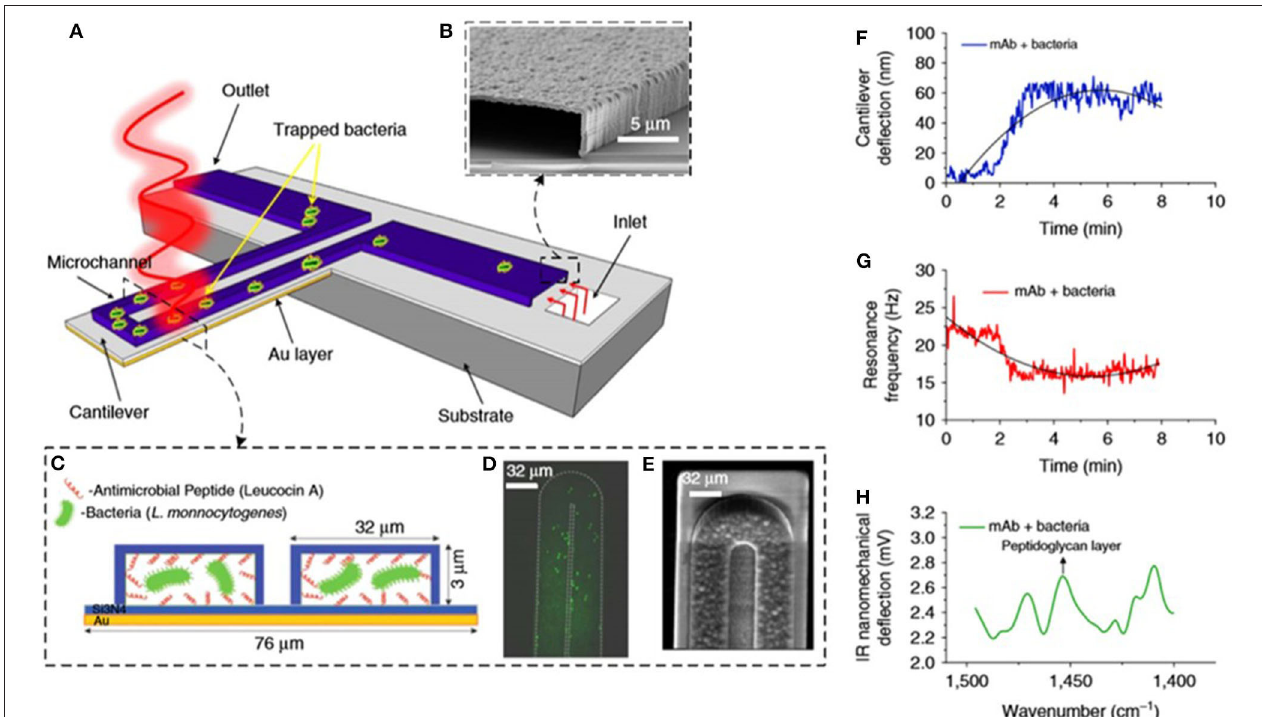
FIGURE 4 | Bacteria detection with multimode nanomechanical sensors. (A) Schematic representation of the microfluidic gold-coated cantilever. (B) Cross-section SEM image of the inlet channel. (C) Cross-section of the functionalized microchannel with adsorbed bacteria. (D) Fluorescent image and (E) SEM image of the tip of the microfluidic cantilever containing bacteria. (F) Changes in cantilever deflection with time induced by trapped bacteria. (G) Changes in resonance frequency with time induced by trapped bacteria. (H) Infrared absorption spectra of trapped bacteria obtained by measuring the cantilever deflection induced by illumination with infrared light. Reprinted from Etayash et al. (2016) with permission from the Nature Publishing